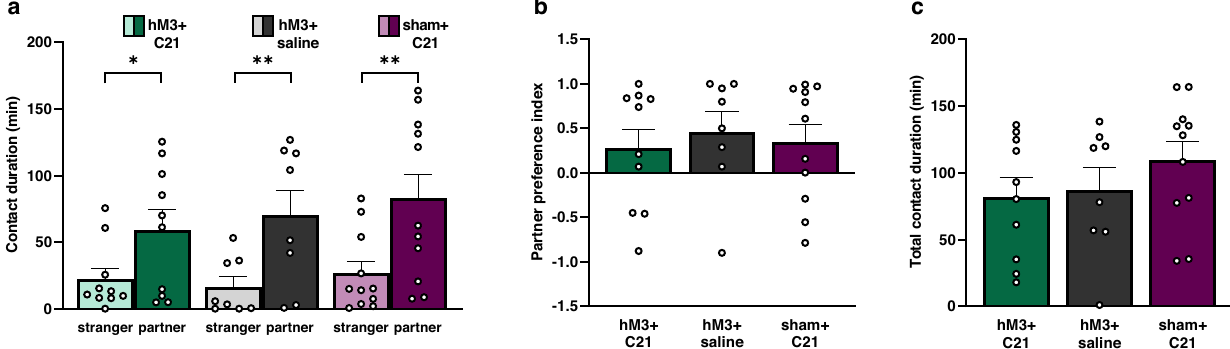
Fig. 3 LS activation does not alter partner preference formation. a Contact duration (min, minutes) when hM3 + C21 (green bars), hM3 + saline (gray bars), and sham + C21 (purple bars) subjects spent time with the stranger (light color bars) or partner (dark color bars) stimulus females. b Partner preference index (contact duration with partner − contact duration with stranger)/(contact duration with partner + contact duration with stranger). c Total contact duration (min) with both the stranger and partner (contact duration with partner + contact duration with stranger). Data are presented as mean ± SEM. Dots represent individual data for hM3 + C21 ( n = 10), hM3 + saline ( n = 8), and sham + C21 ( n = 11) subjects. * p < 0.05; ** p <